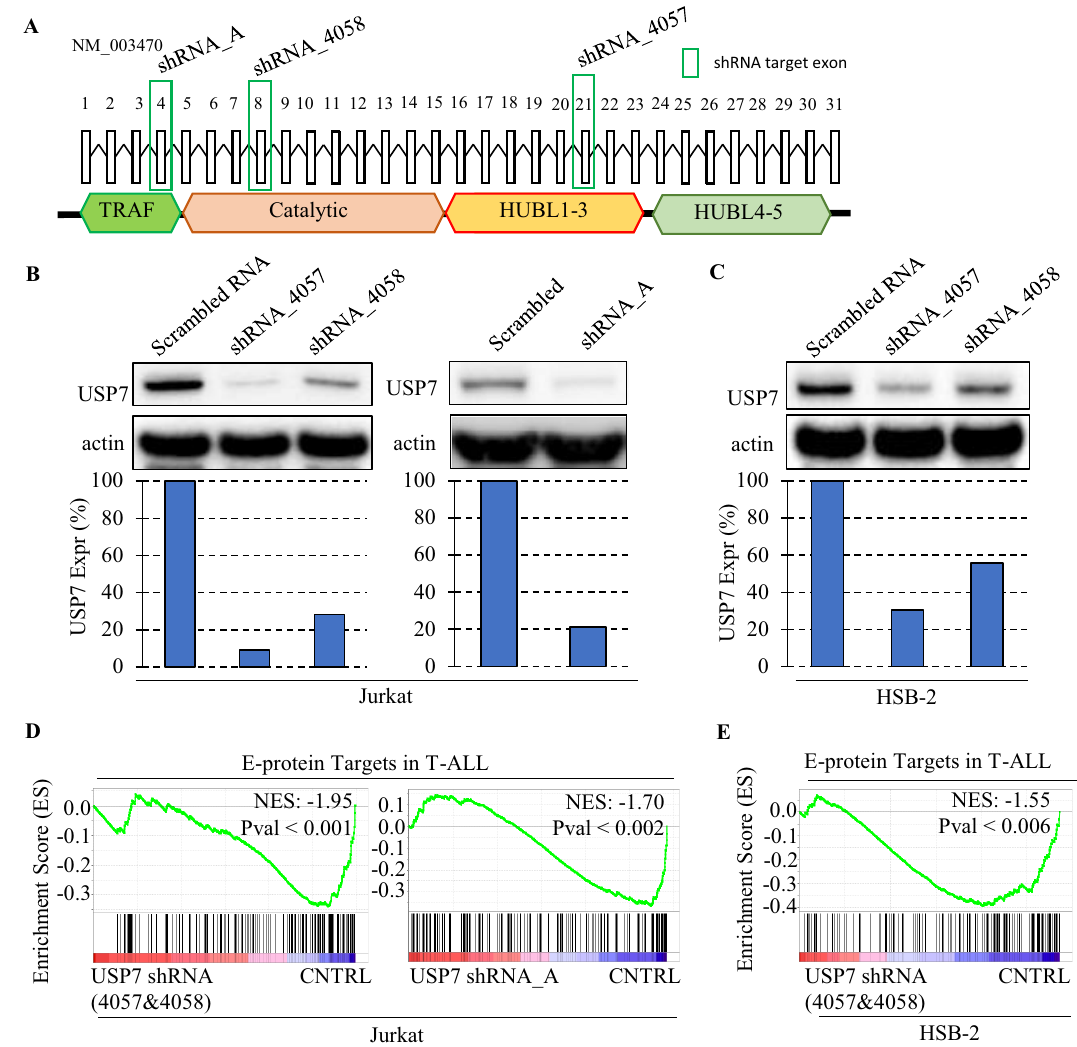
Figure 3. USP7 knock-down in T-ALL cell lines inhibits E-protein targets. Short hairpin RNAs (shRNA) targeting exon 4, 8, and 21 used for knock-down experiments ( A ). Western blot showing the reduction of USP7 protein after shRNA knock-down with the bar plot showing the actin normalized USP7 expression in Jurkat ( B ) and HSB-2 ( C ). GSEA analysis showing shRNA knock-down reduces the expression of E-protein targets compared to the controls in Jurkat ( D ) and HSB-2 ( E ). The number of RNA-seq samples used for this analysis is shown in Supplementary Table